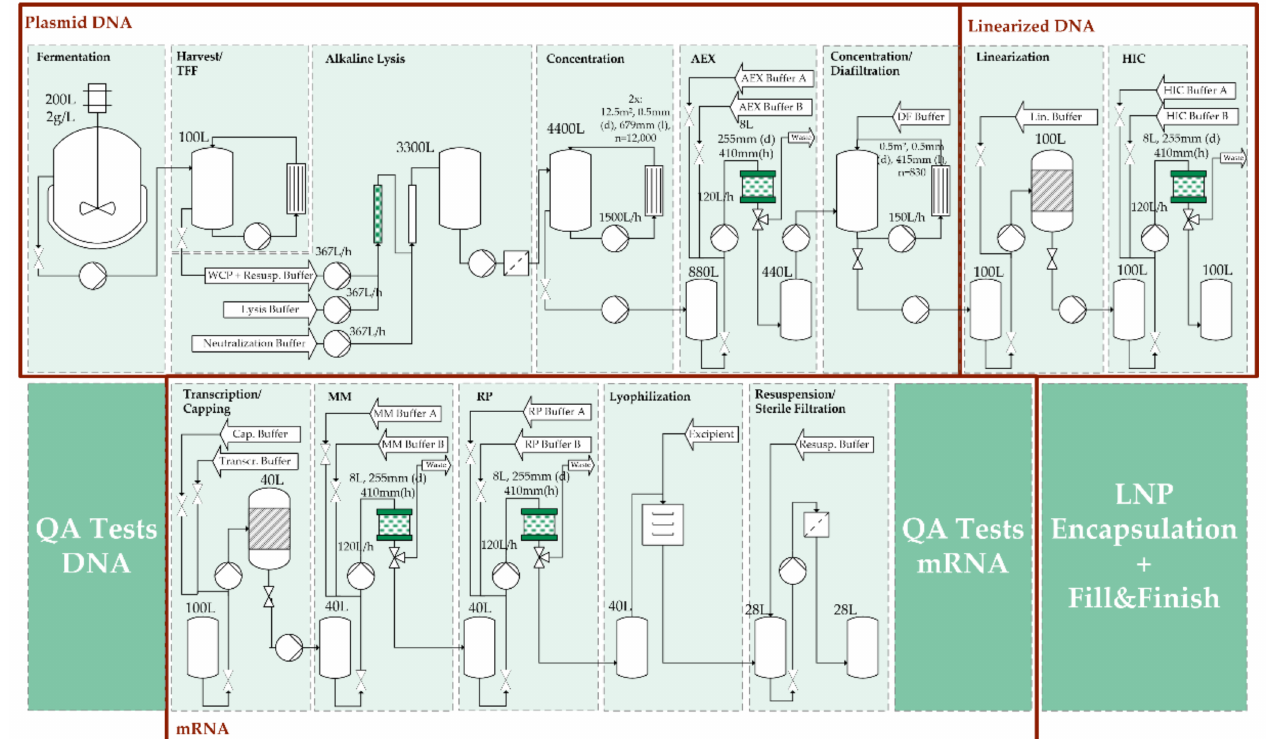
Figure 2. Flowsheet of base-scenario adapted from Schmidt et al.